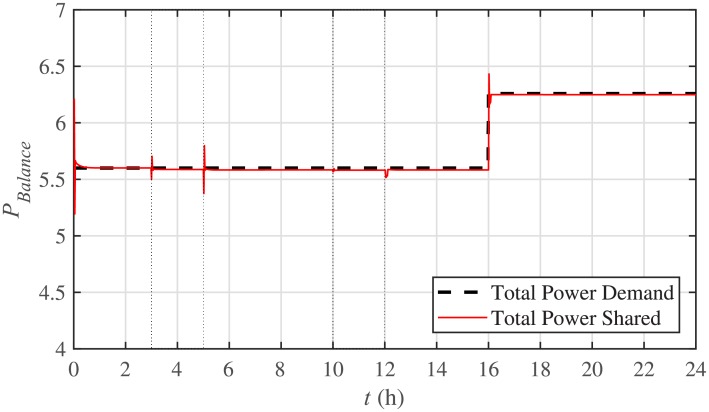
Power balance under case 2.